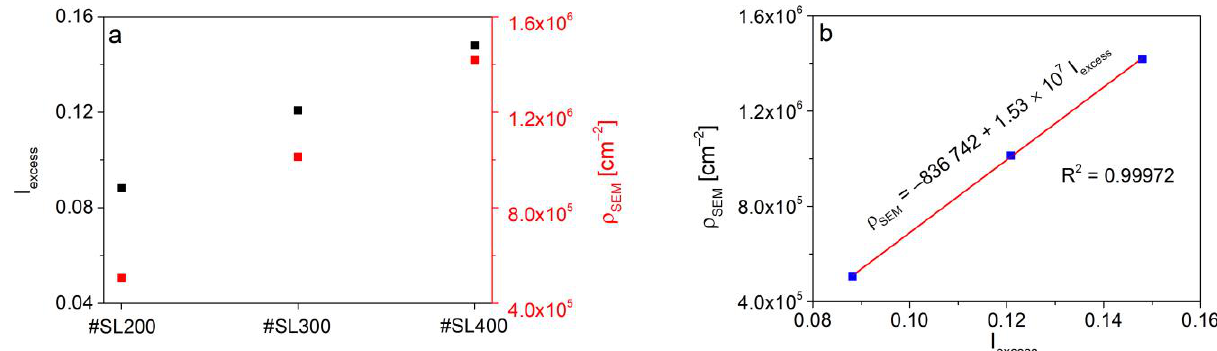
Figure 3. ( a ) The excess intensity (black points) obtained from the integration of diffuse scattering and defects density ( ρ SEM ) (red points) estimated from SEM images made for investigated superlattices. ( b ) Linear dependence of ρ SEM as a function of excess intensity (blue points — experimental data, red line — linear fit).